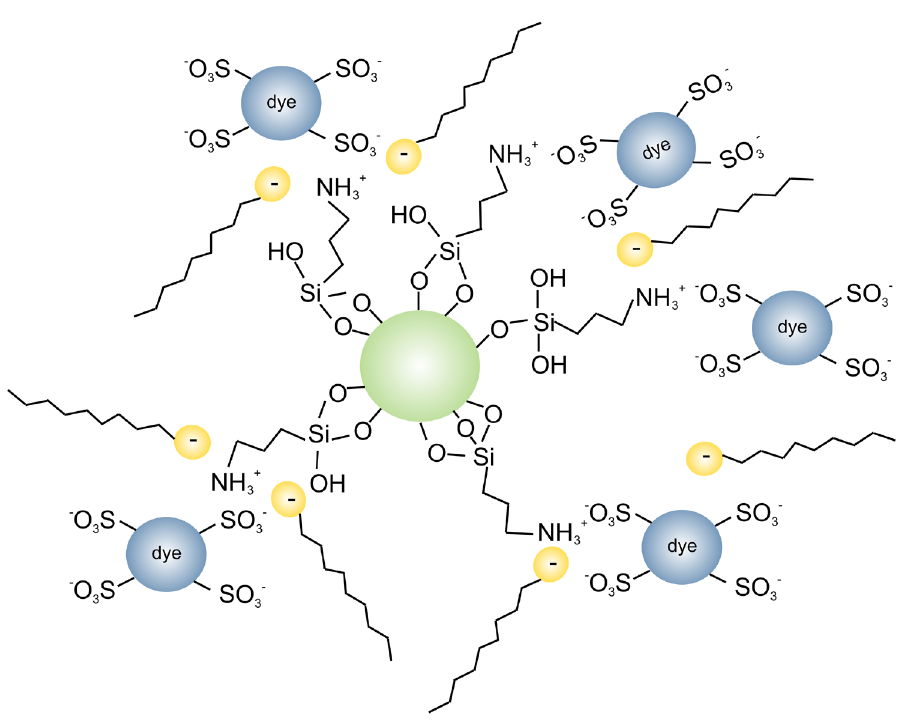
Figure 6: Possible interactions between dye ( e.g . C.I. Reactive Black 5 or C.I. Direct Blue 71) and aminosilane modified silica in the presence of anionic surfactant in acidic medium.